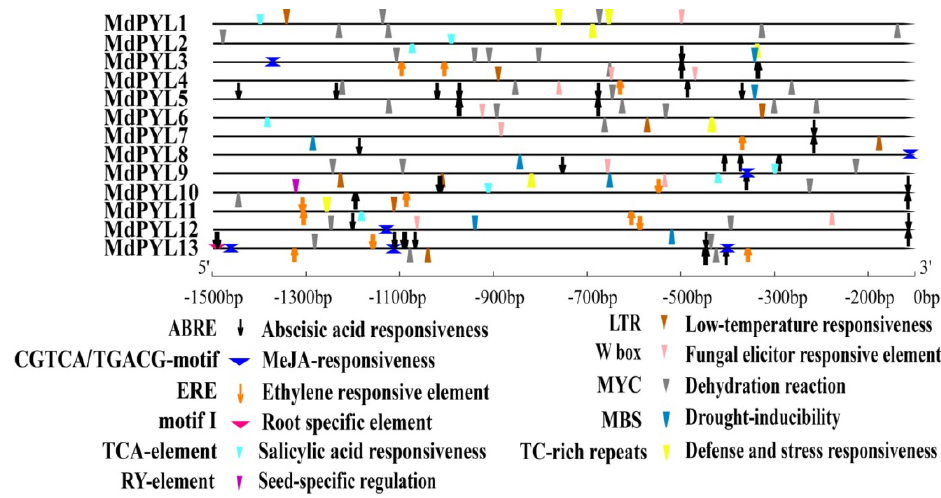
Figure 7. The cis-elements analysis in MdPYL promoters. The 1500 bp promoter sequences of 13 MdPYLs were analyzed by PlantCARE. The up and down directions respectively denote the cis-elements existing in the plus or minus strand of MdPYL promoters.